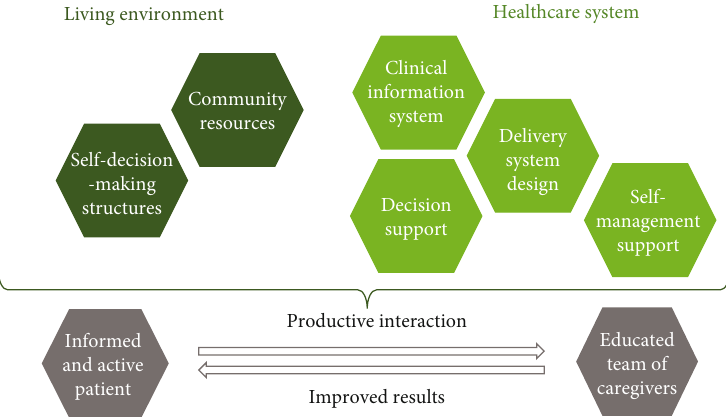
Figure 1: Graphic illustration of the CCM (according to